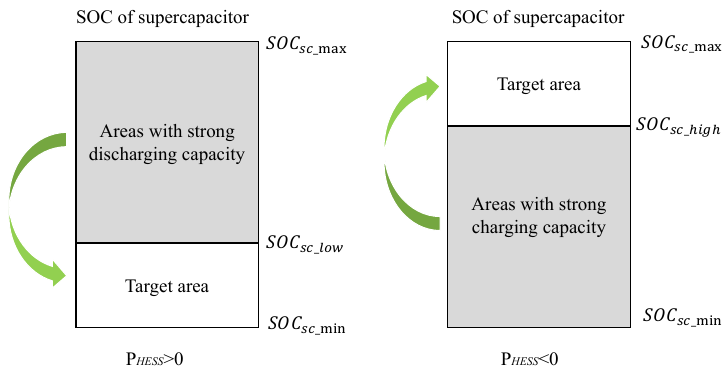
Figure 8. Diagram of supercapacitor state management.